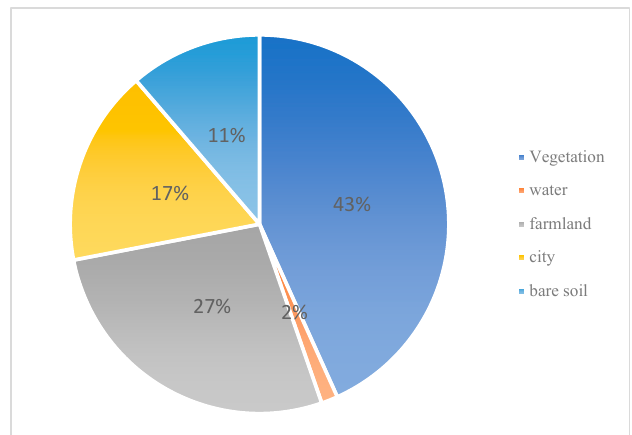
Figure 6. Types and proportion of features in Beijing.